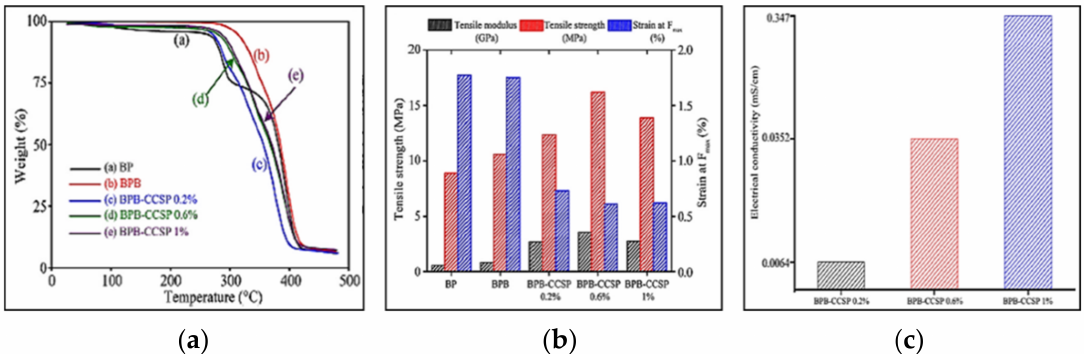
Figure 13. ( a ) TGA of BPB–CCSP composites, ( b ) tensile properties of different systems, and ( c ) electrical conductivity of composites